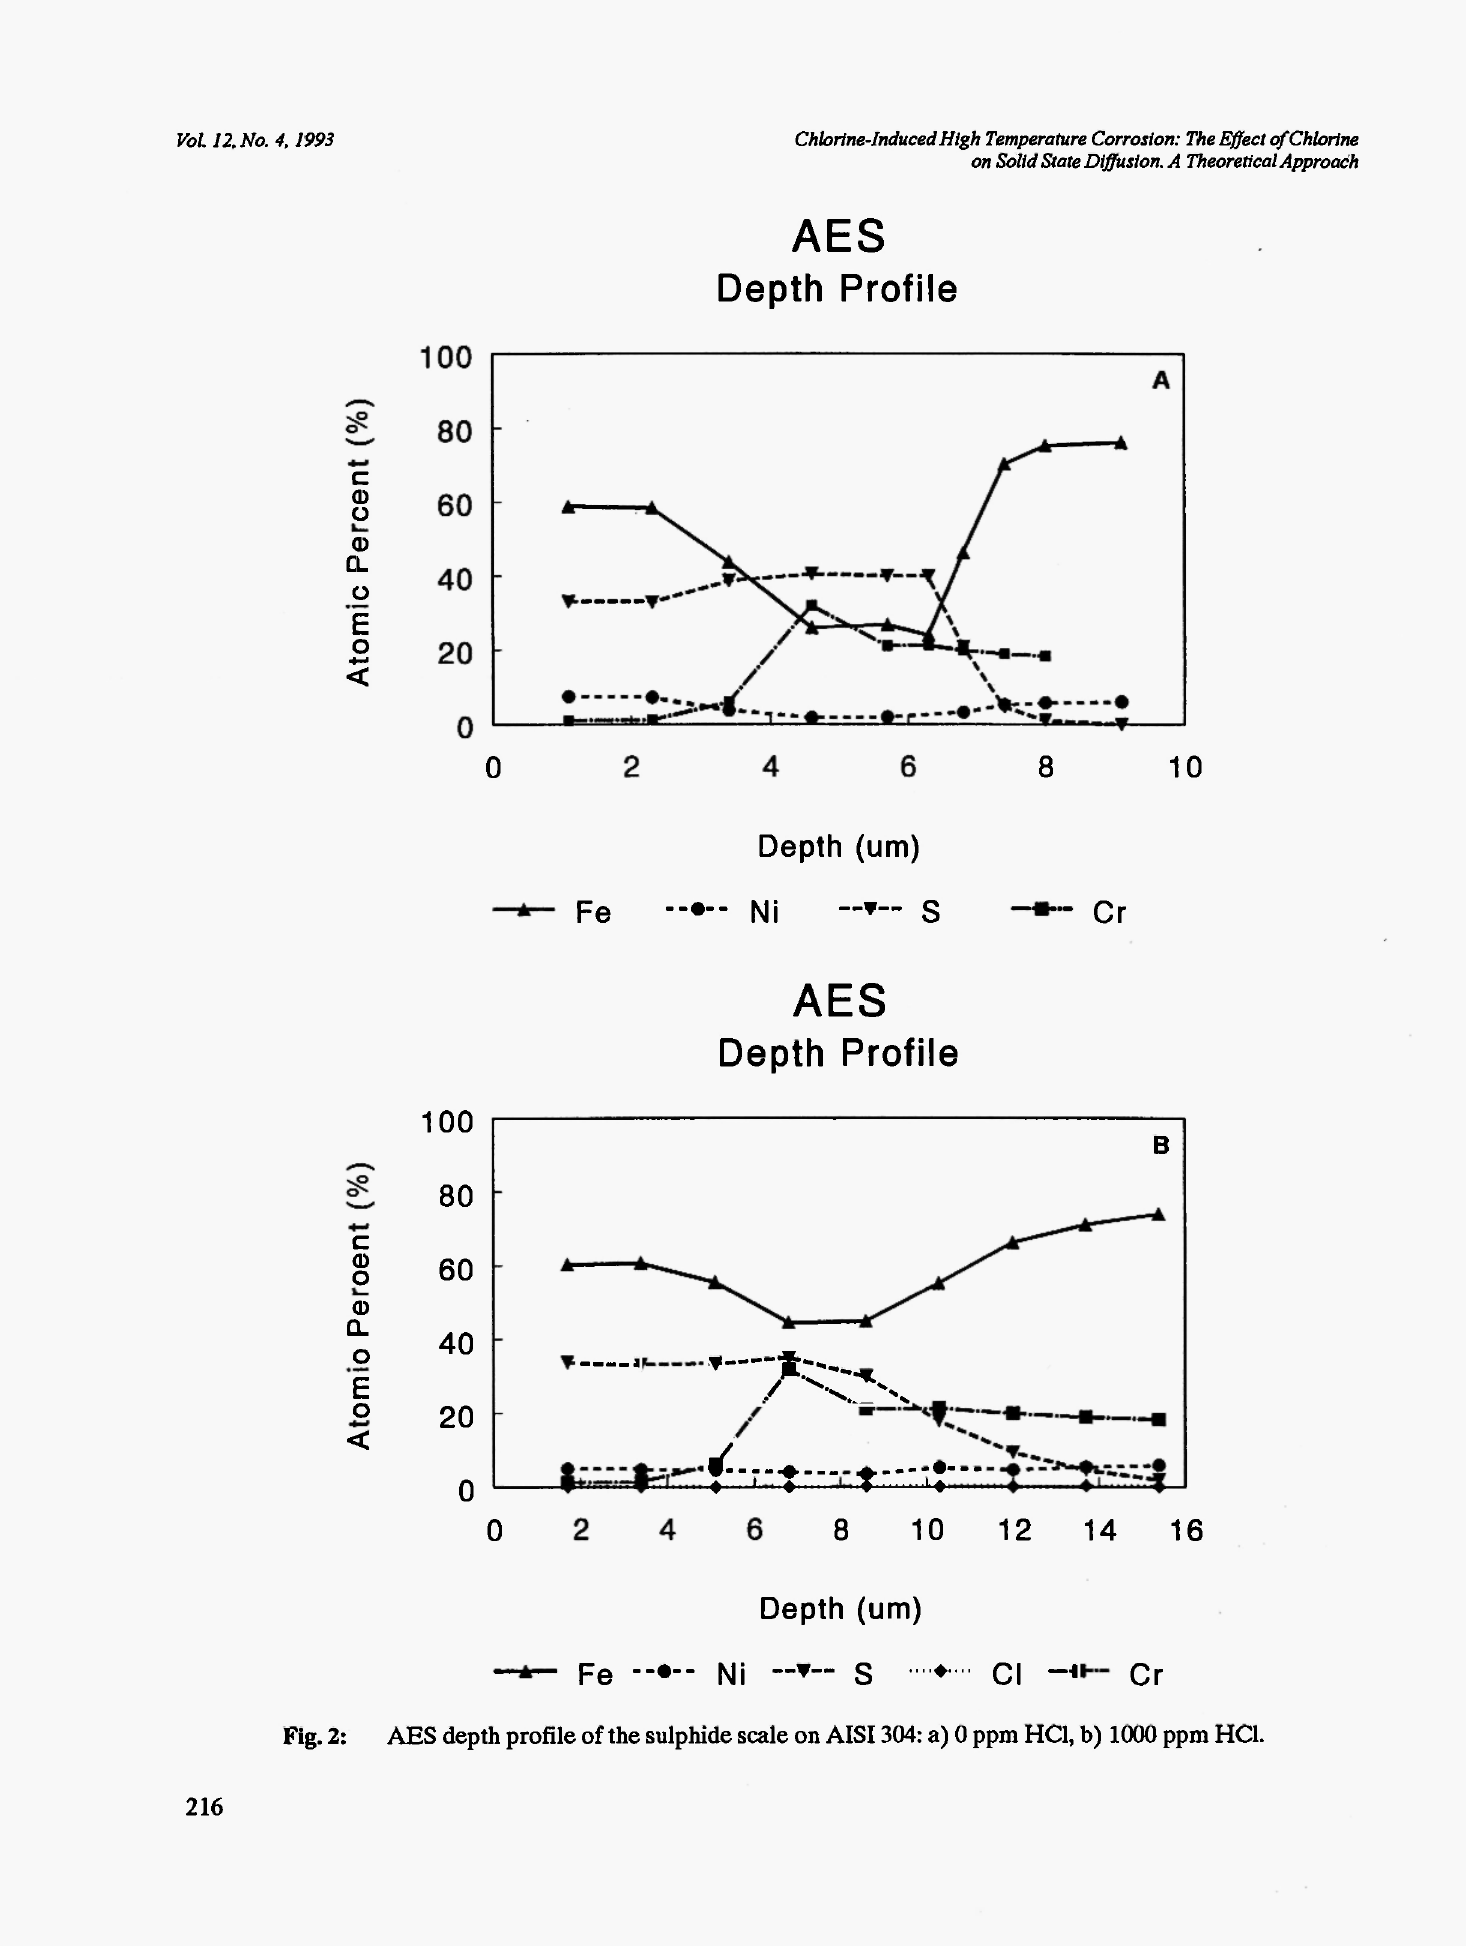
Fig. 2: AES depth profile of the sulphide scale on AISI304: a) 0 ppm HCl, b) 1000 ppm